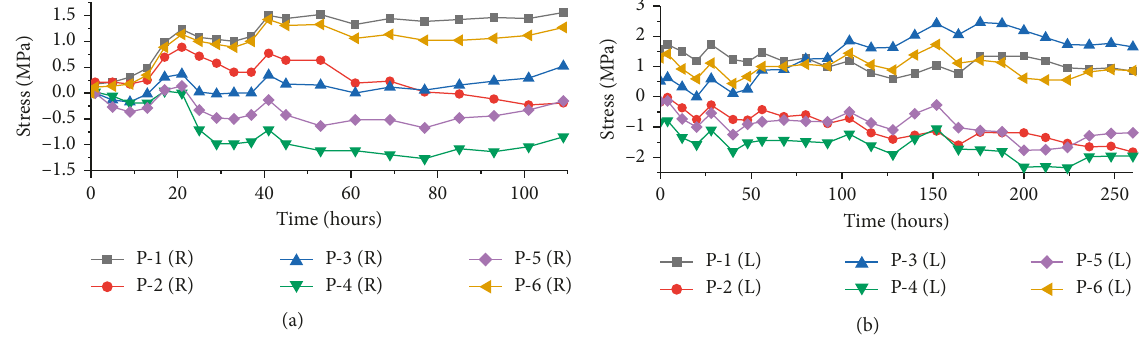
Figure 9: Stress time history curves of the middle partition wall: (a) after the excavation of the right tunnel tube; (b) after the excavation of the left tunnel tube.